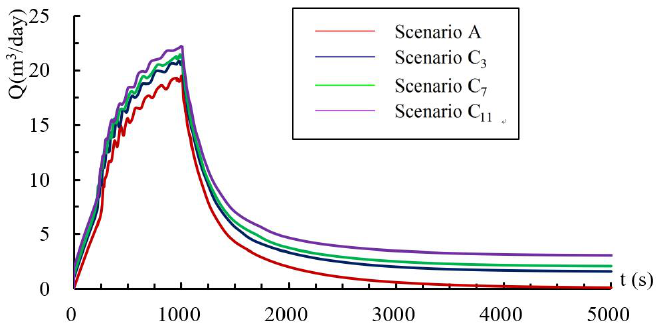
Water 2019 , 11 , 755 11 of 21